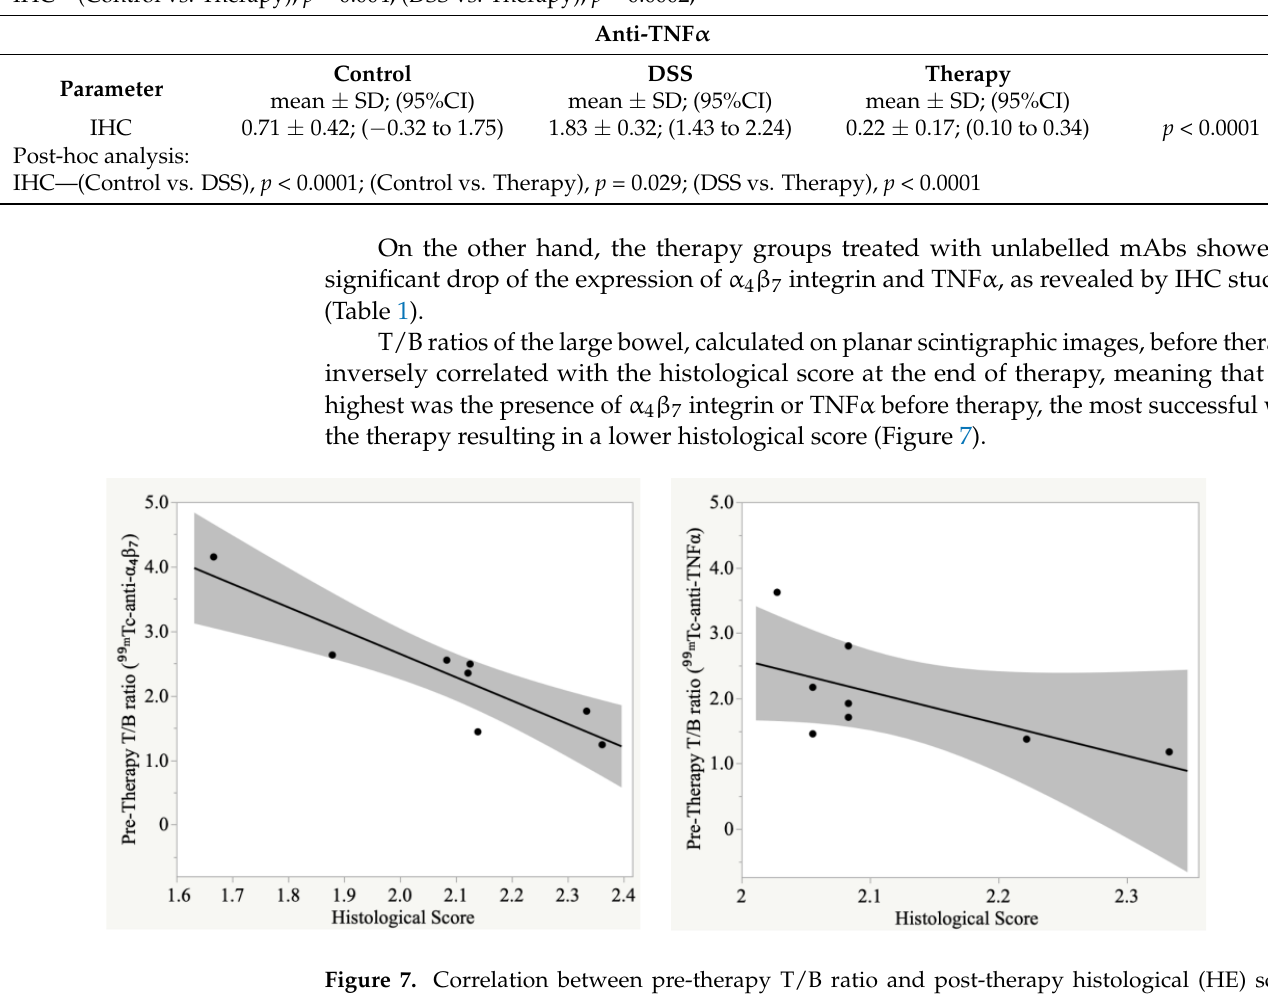
Figure 7. Correlation between pre-therapy T/B ratio and post-therapy histological (HE) score calculated on DSS mice injected with 99m Tc-anti- α 4 β 7 ( left ) or 99m Tc-anti-TNF α ( right ), (r = − 0.72 ( − 0.95 to − 0.04); p = 0.04 and r = − 0.90 ( − 0.98 to − 0.55); p = 0.002, respectively). The highest is the presence of target antigen before therapy, the less is the histological damage at the end of therapy. This is more evident for mice treated with anti- α 4 β 7 mAb. Gray area = confidence interval.